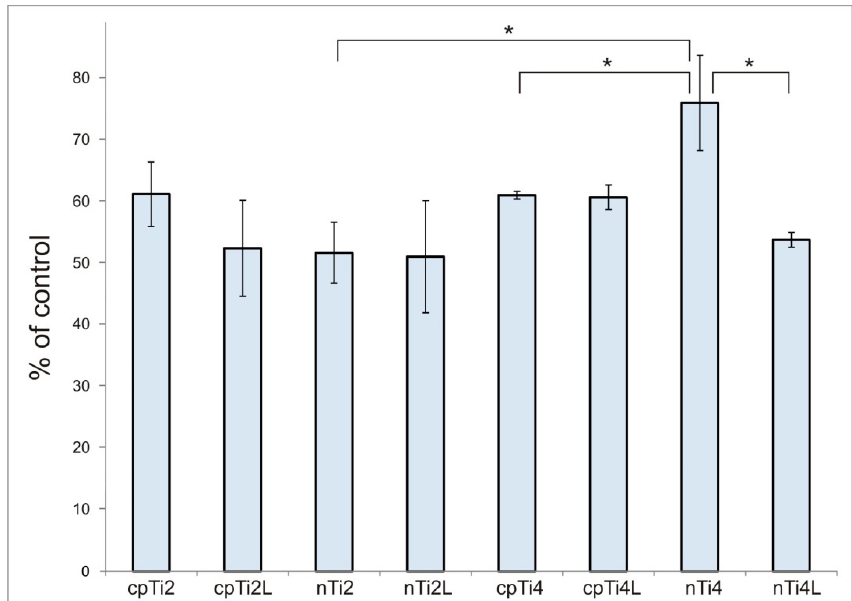
Figure 4. Comparison of the proliferation of osteoblasts on eight versions of titanium surfaces. The data is expressed as % of control. Error bars indicate means ± standard deviations; *, **, *** denotes statistically significant differences of p < 0.05, p < 0.01 and p < 0.001, respectively.